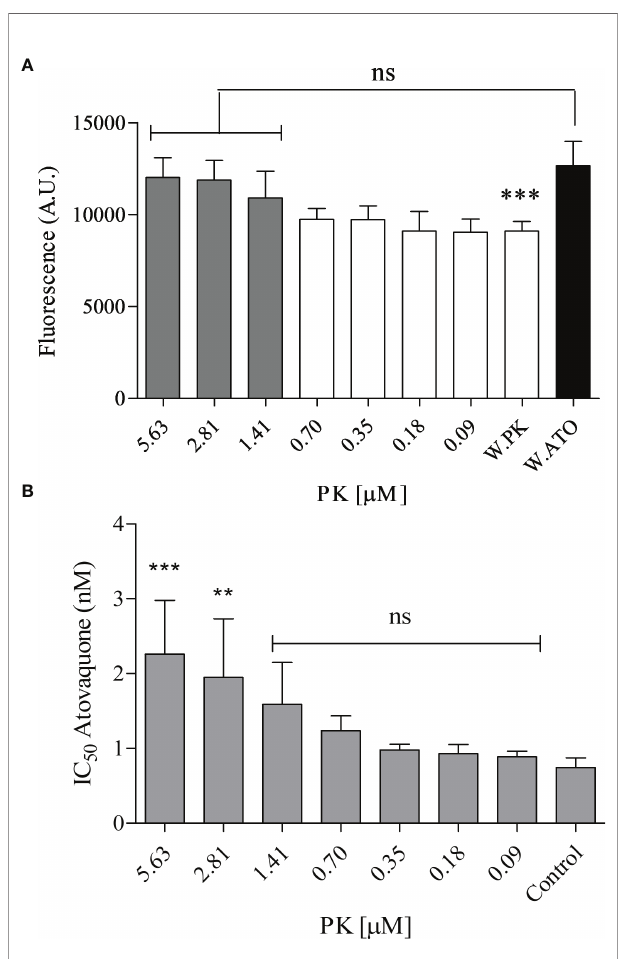
FIGURE 8 | Phylloquinone effects onatovaquone-treatedparasites. (A) Parasites were treated or not (without atovaquone; W.ATO)for 48 h with 0.6 nM ATO.At the same time, PK was applied or not (without phylloquinone; W. PK)at different concentrationsranging from0.09 to 5.63 µM. (B) The IC 50 value of ATO for parasiticgrowth was estimated at different concentrationsof PK. The increase in fl uorescence meansa low inhibition of the parasite growth.Control: the IC 50 of ATO withoutPK. Parasite growth was estimated by the DNA staining protocol described in section 2.14. One-way ANOVA followed by Dunnett ’ s posttestwas used for statistical analysis. ***, p < 0.001; **, p < 0.01; ns, difference not statistically signi fi cant. Allexperiments wereperformed